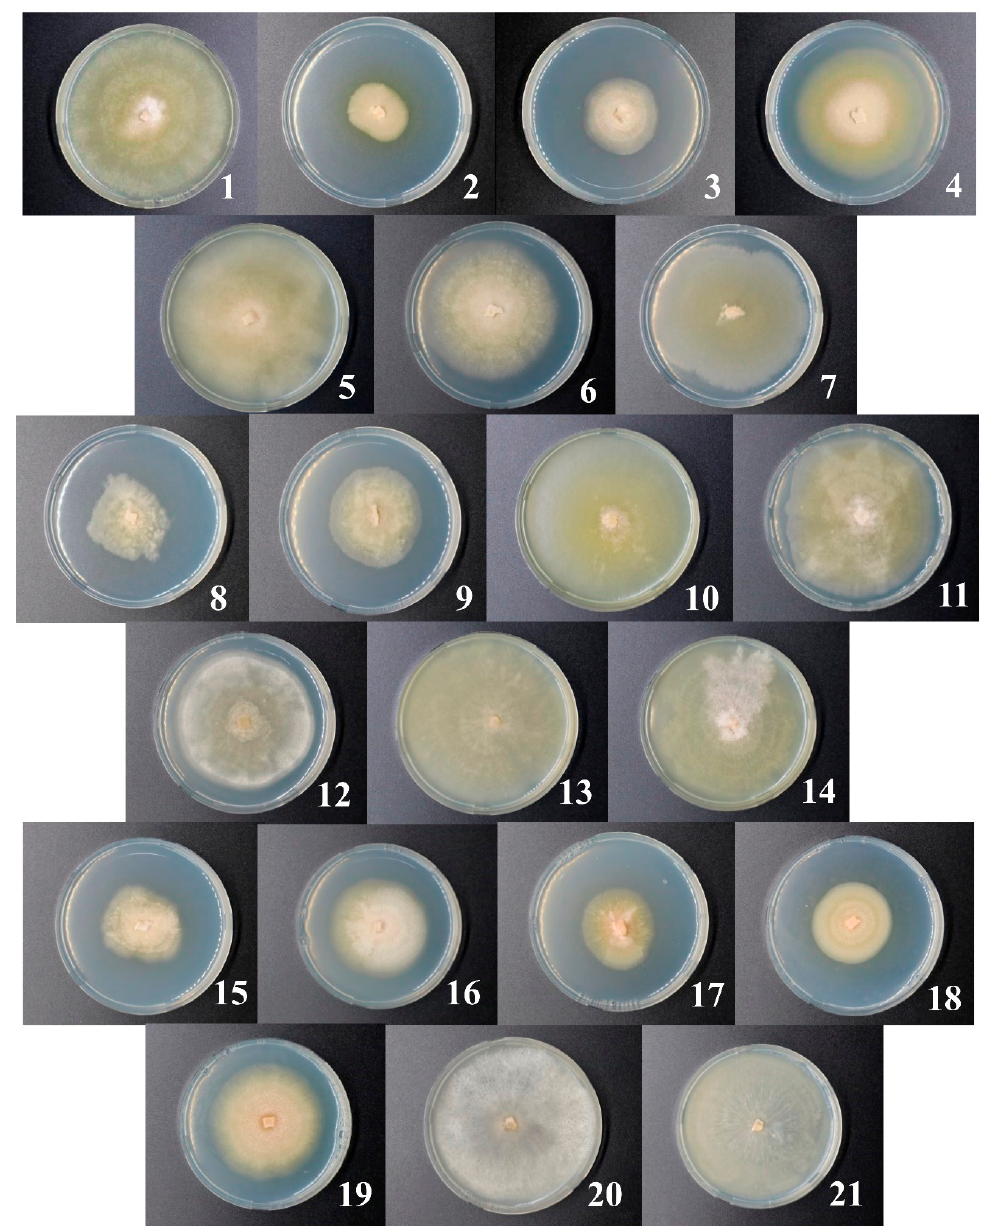
Figure 6. Morphology of the isolated candidate Microdochium sp. strains. The number on a photo corresponds to the number of a strain. The photos were made 14 days after inoculation. The isolated strains had different growth rates (Figure 7) ranging from 1 to 6 mm per day. The strains 1, 5, 13, 14, 20, and 21 were characterized by the fastest growth, while the growth rate of strains 2, 3, 8, 17, and 18 was the lowest. Seven strains (1, 3, 5, 10, 14, 17, and 19) formed conidia typical of M. nivale sensu stricto [17] with 0–3 septa and sizes of 10.1–20.3 µm length and 1.8–4.1 µm width depending on the strain (Table S13, Supplementary Materials).